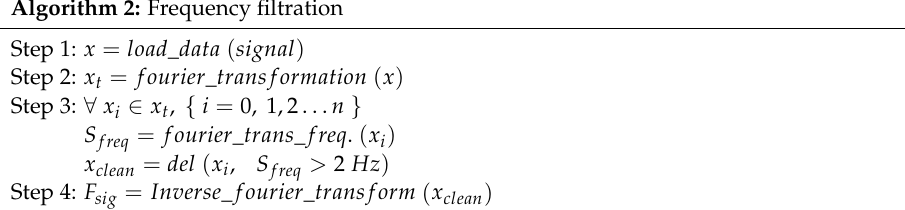
Algorithm 2: Frequency filtration